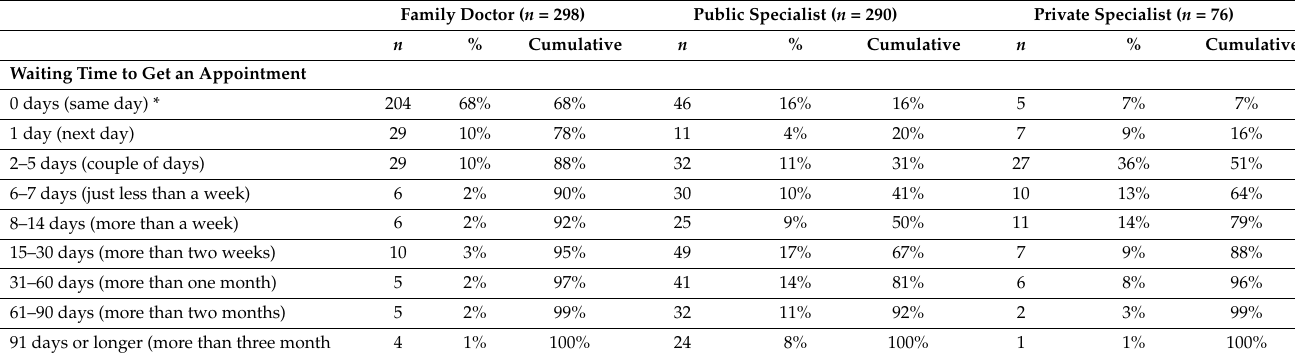
Table 2. Waiting time to get an appointment by type of